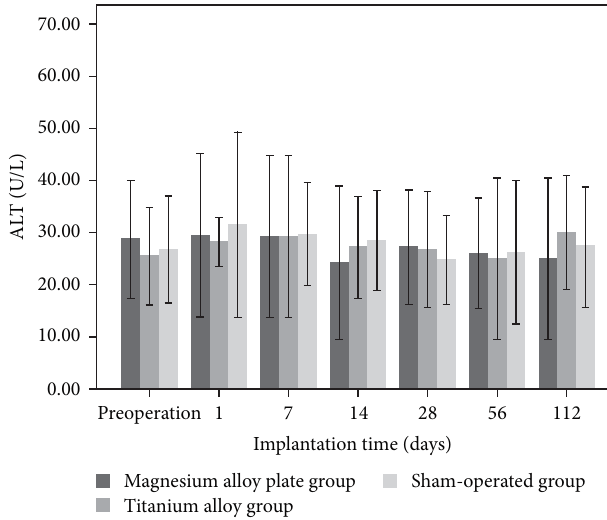
F IGURE 3: Results of ALT levels before and after surgery in each group ( ∗ P < 0 :